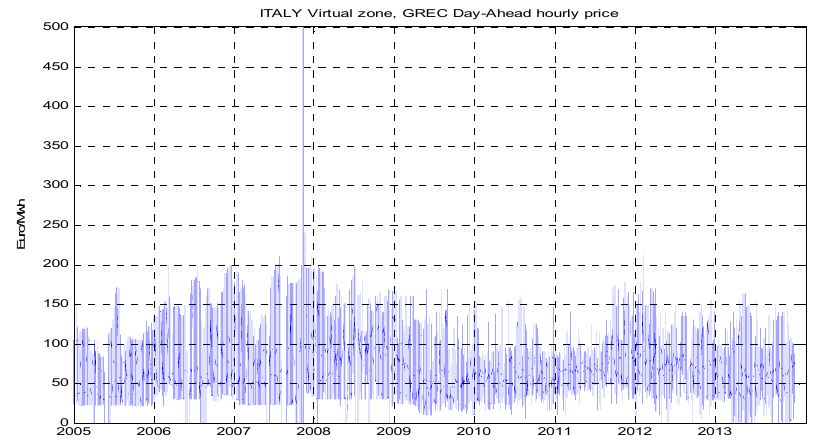
Figure 1. Italy’s electricity market GREC zone’s day-ahead price, hourly data,